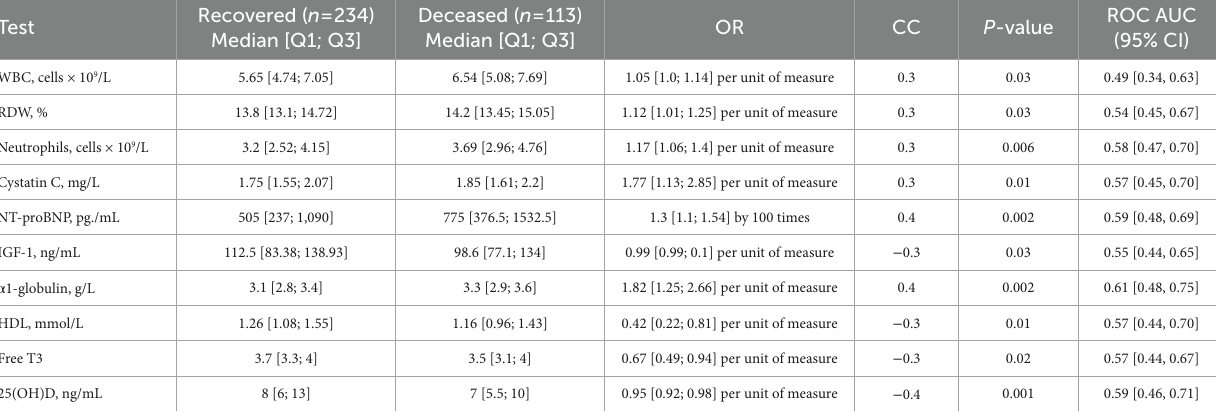
TABLE 6 First-stage test results of the participants who recovered or died from COVID-19 (significantly different), adjusted for age, sex, and multiple